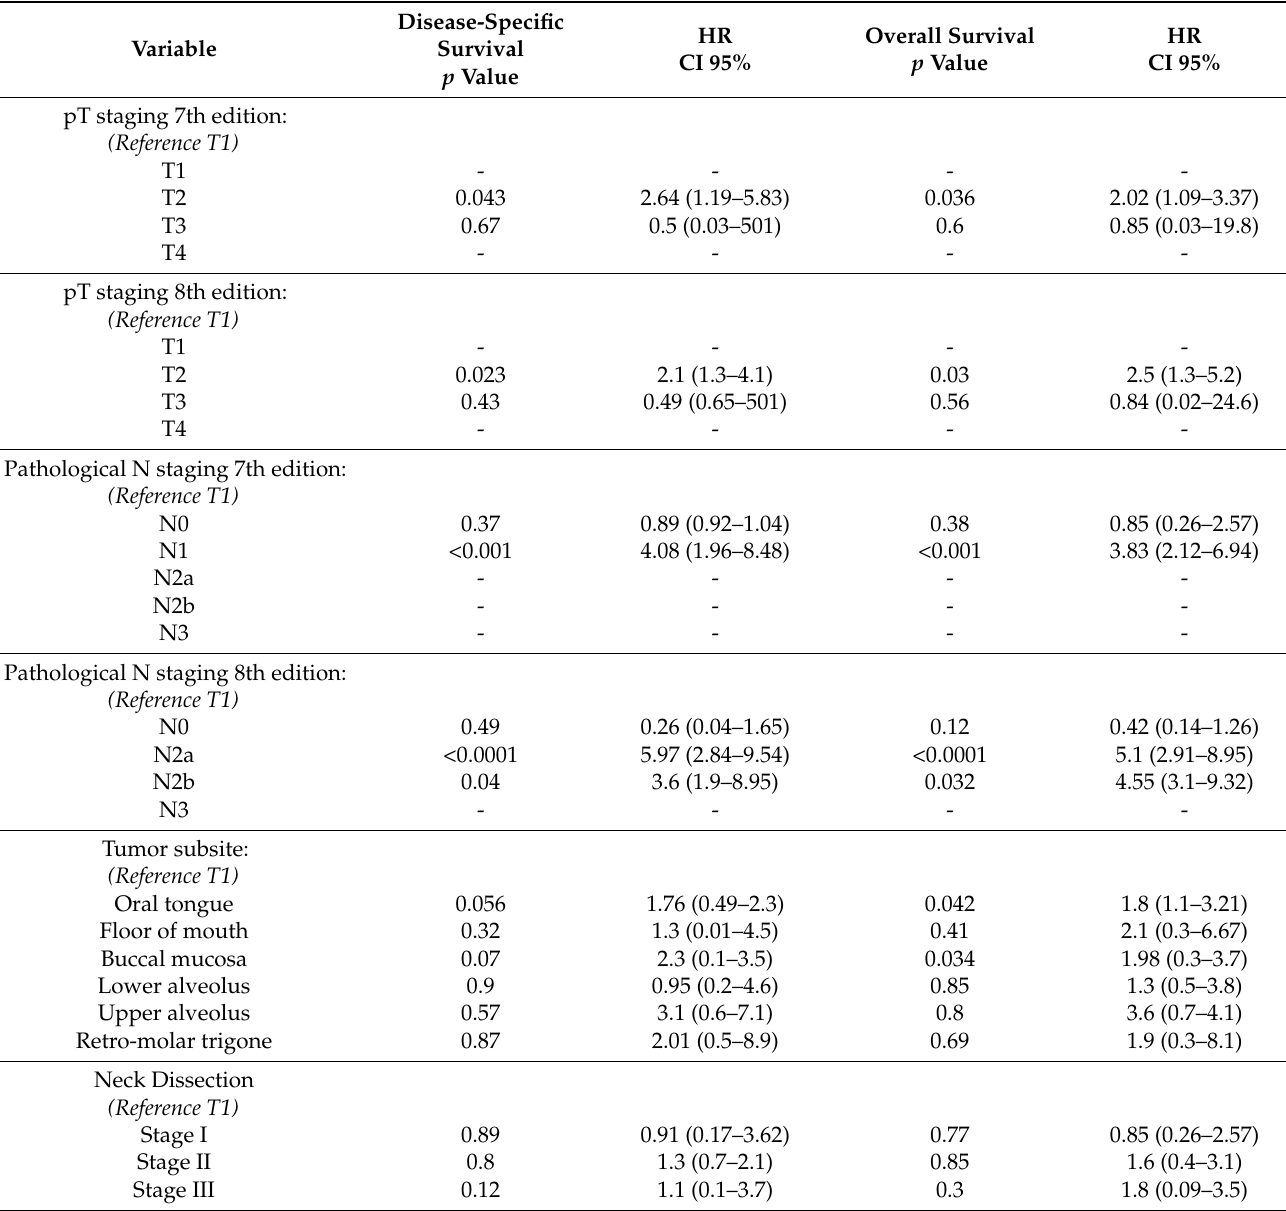
Table 2. Multivariate analysis of the study cohort, pT1 was used as a